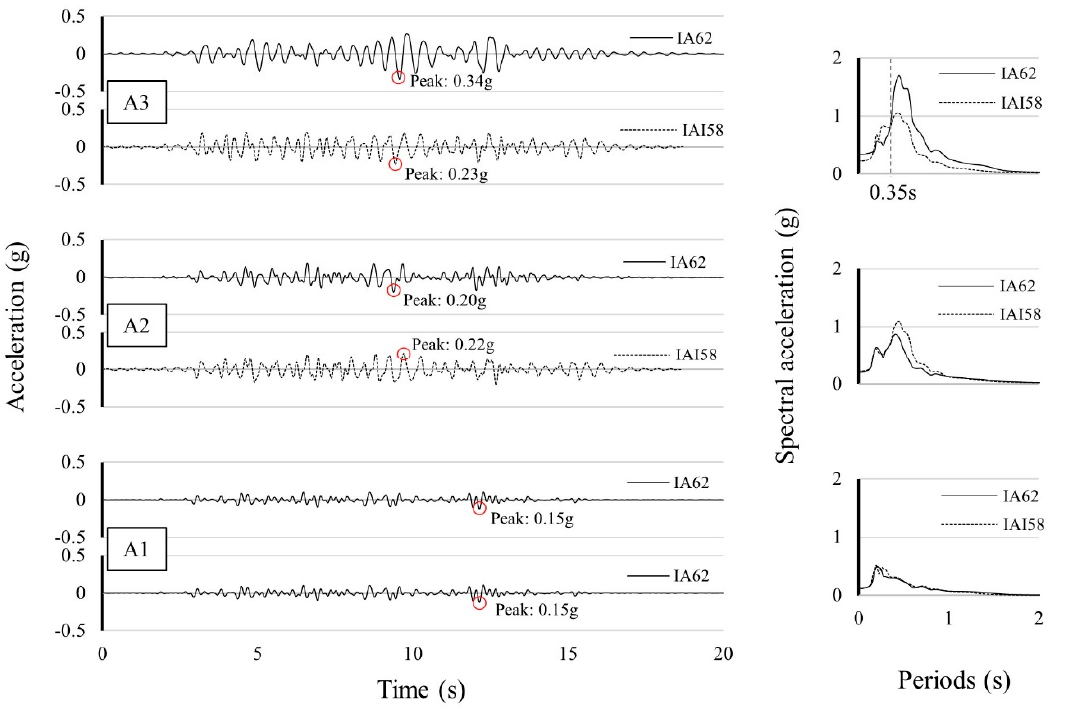
Figure 7. Acceleration time histories of inclined ground model (0.12 g) (scaled to the prototype).